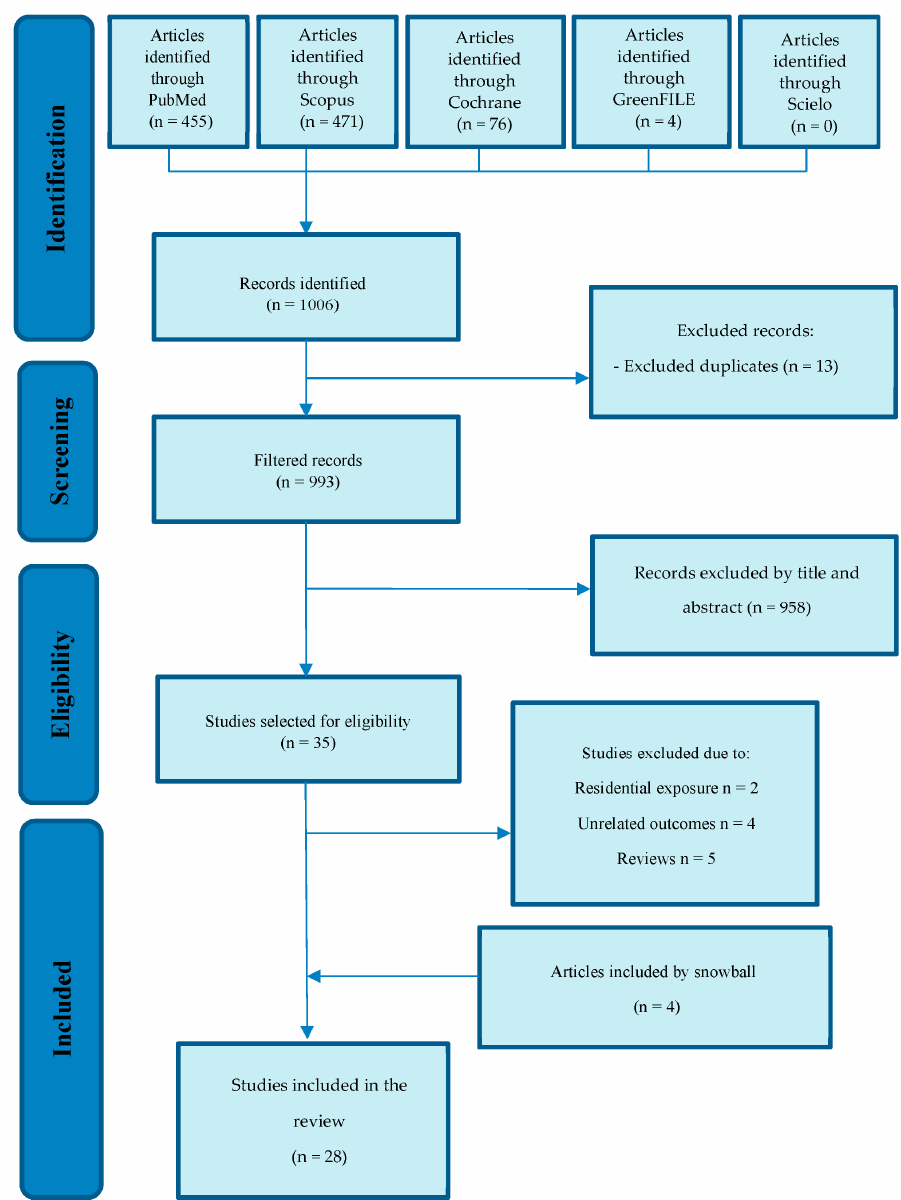
Figure 1. PRISMA-P flowchart of the stepwise assessment of articles obtained from the search strategy.